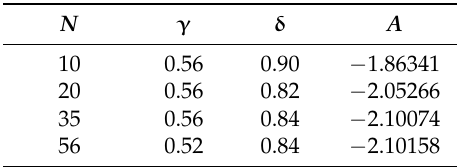
Table 3. Convergence of the scattering length for e + -H scattering with respect to the number of correlation terms N